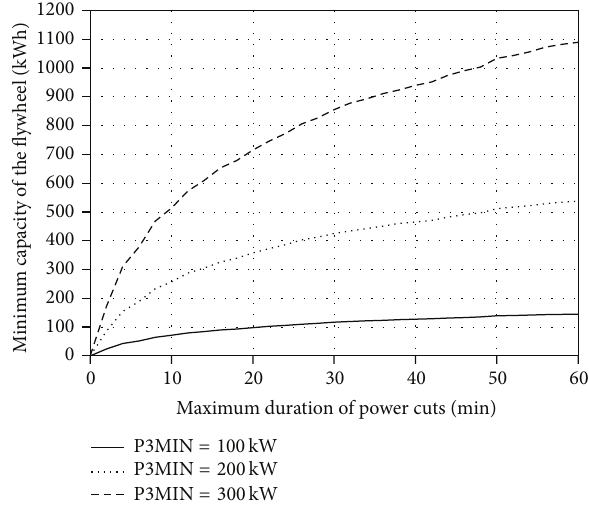
= 𝑓(𝑇 ) for Enercon Figure 6: Family of characteristics 𝐴 ESMIN MAX E53 turbine, height: ℎ 𝑤 = 60 m for the period between 1 June 2010 and 31 Aug. 2010.